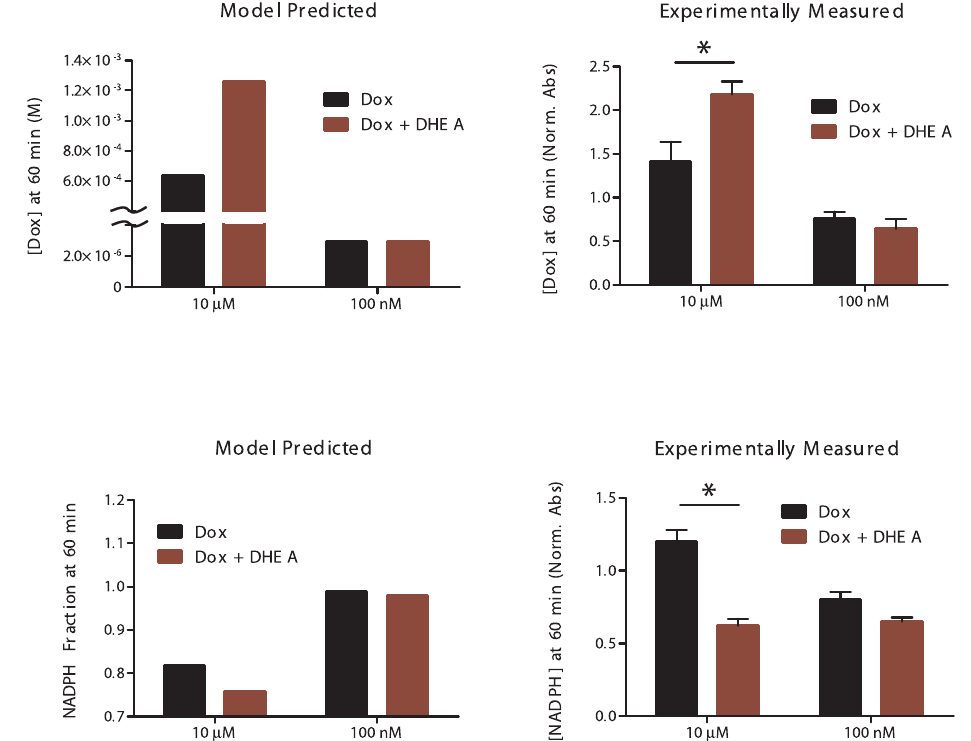
Figure 4. Effects of pharmacological intervention on doxorubicin reductive conversion in EU3-Sens cells. (A) Model-predicted and experimentally determined quinone doxorubicin accumulation in EU3-Sens cells, with and without DHEA intervention, at the 10 m M and 100 nM doxorubicin concentration conditions. (B) Model-predicted and experimentally determined NADPH depletion in EU3-Sens cells, with and without DHEA intervention, at the 10 m M and 100 nM doxorubicin concentration conditions. (DHEA=10 m M, 24 hrs; *p , 0.05).